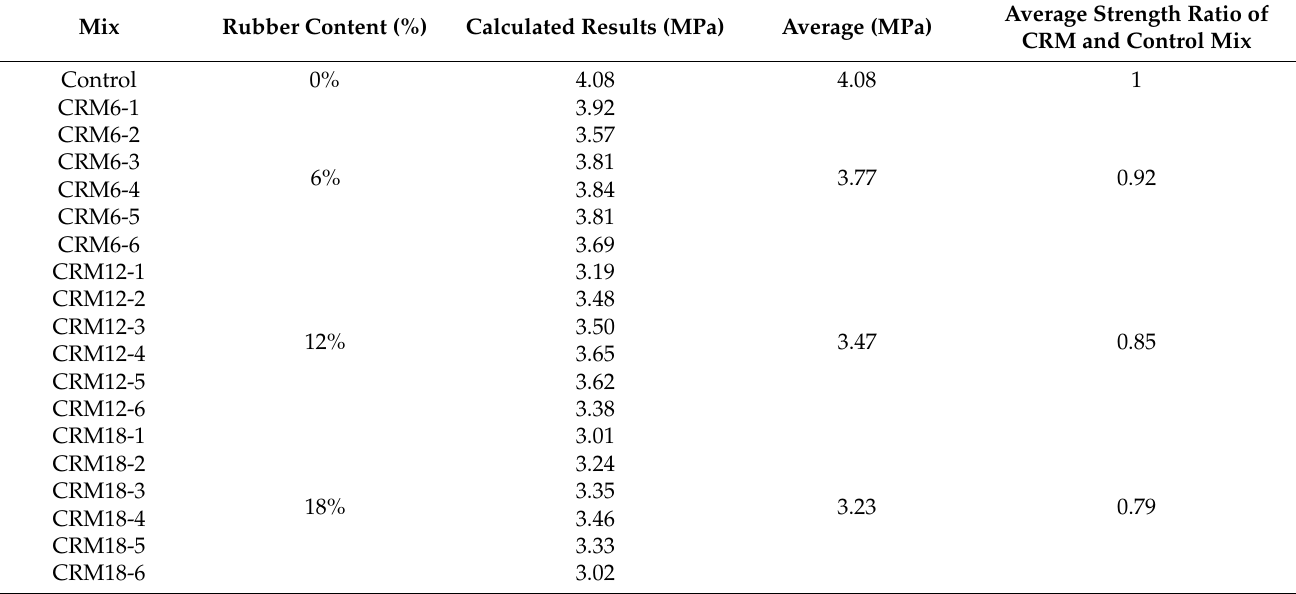
Table 7. The tensile strength of CRM obtained by numerical simulation.